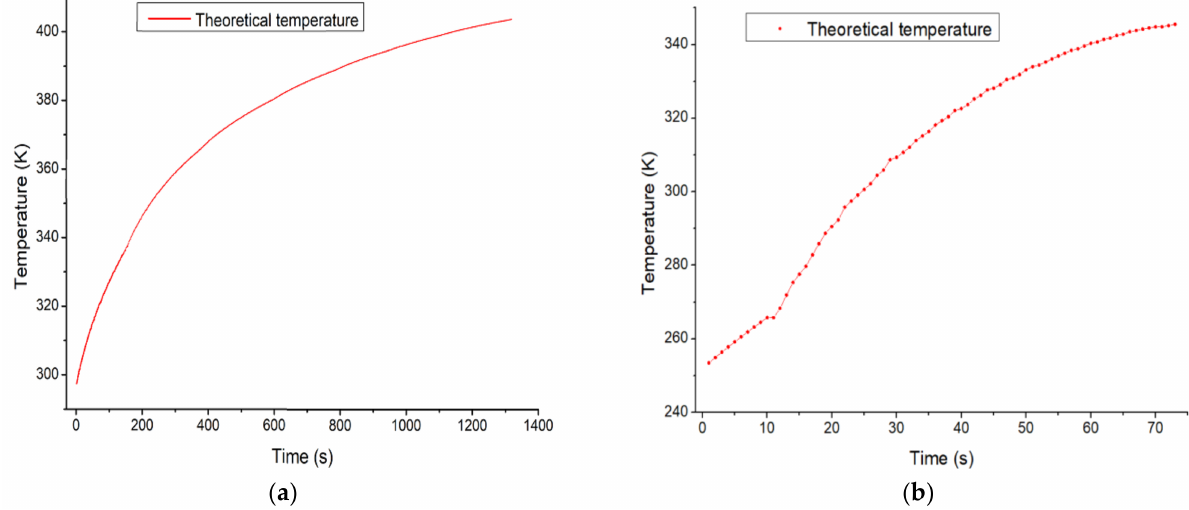
Figure 10. The theoretical results of the temperature for the second cycle. ( a ) Temperature values of the high-pressure tank, and ( b ) temperature values of the buffer